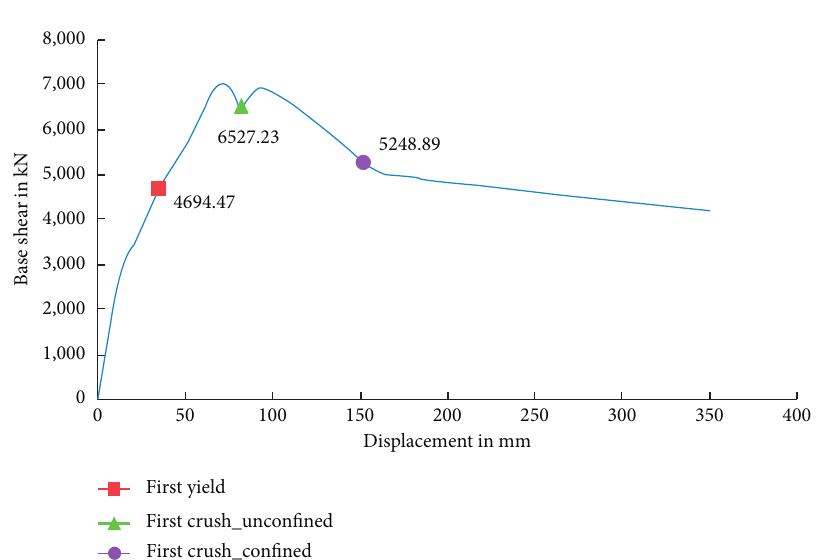
Figure 10: Damage pattern of full RC-infilled frame in Y